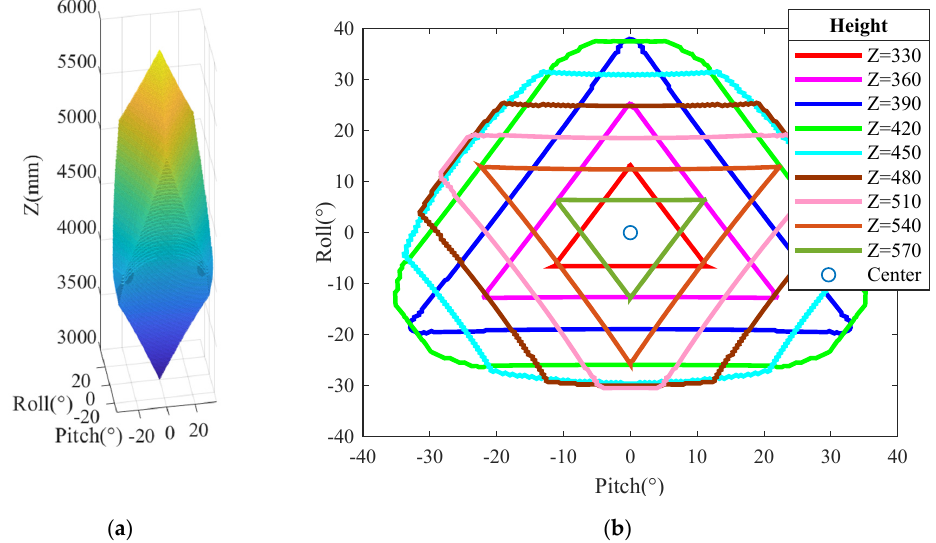
Figure 5. Attitude workspace of 3-RPS compensation platform, ( a ) is the attitude workspace image, ( b ) is a contour map derived from the attitude workspace. Take a point in the contour map and introduce the vector from the central point to the point. The length of the vector represents the deflection angle degree value and the direction of the vector represents the deflection direction. Such as a point within a contour. It indicates that the angle of this platform pose represented by this point can be realized at this height.